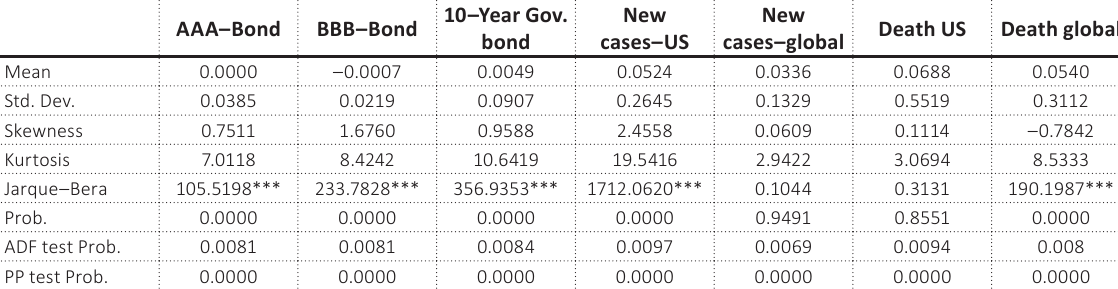
Table 1. Descriptive statistics for the bond yield and the COVID-19